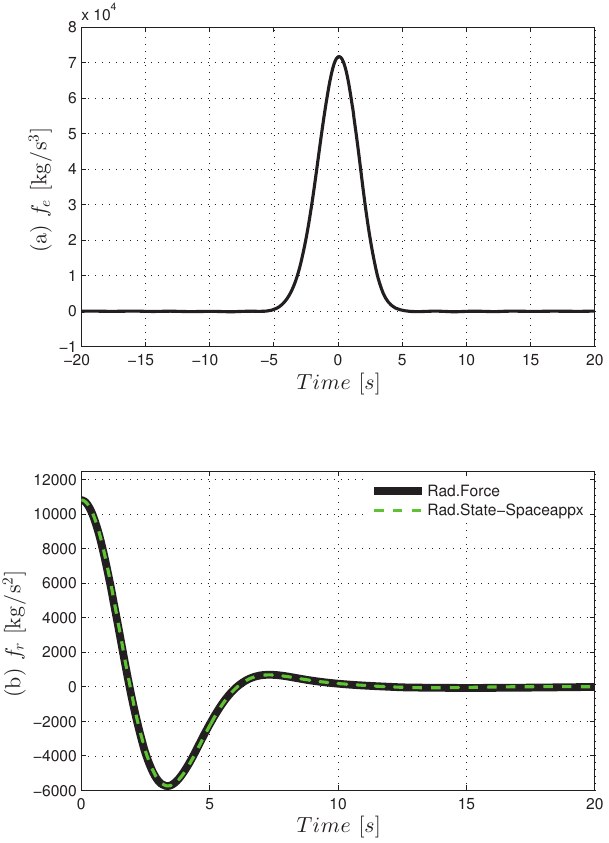
Figure 3. Impulseresponsefunctions: ( a )excitationforce; ( b